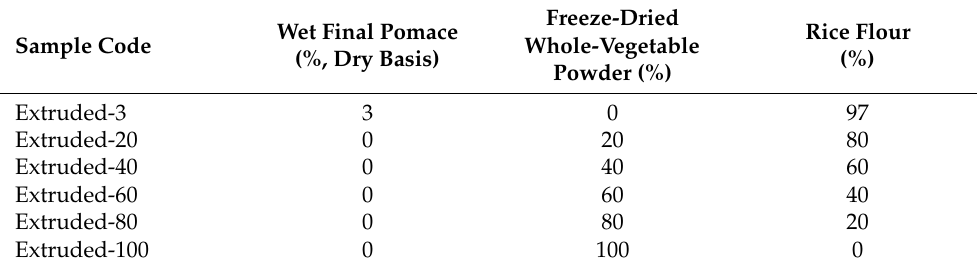
Table 1. Powdered formulation mixtures for extrusion (powder from Trial 2 and pomace from Trial 1).